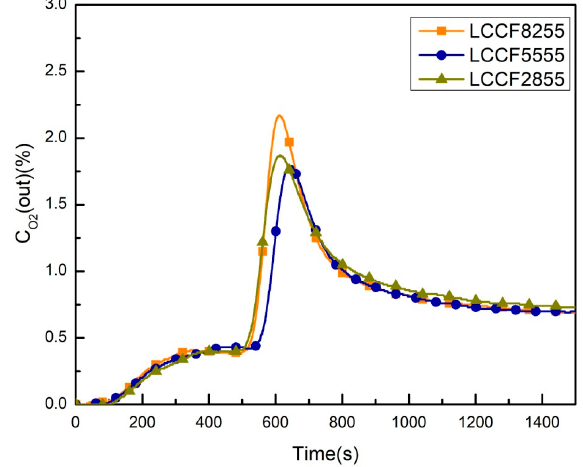
Figure 6. Oxygen desorption curves of La 1-x Ca x Co 0.5 Fe 0.5 O 3- δ (x = 0.2, 0.5, 0.8). Figure 7. Oxygen desorption curves of La 0.5 Ca 0.5 Co 1 − y Fe y O 3 − δ (y = 0.2, 0.5,